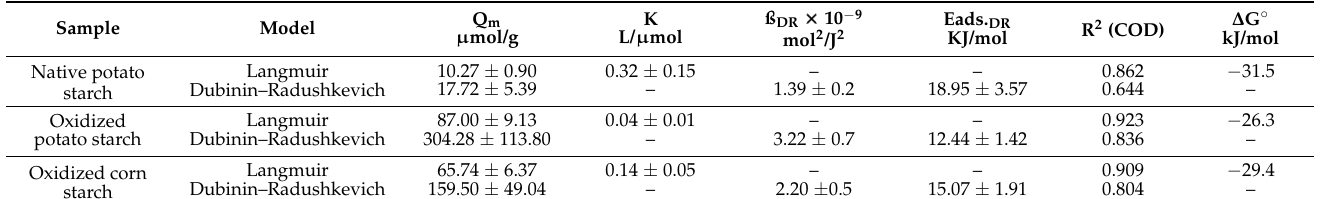
Table 3. Fitting parameters for the adsorption of Fe 2+ from FeSO 4 solution onto n. potato starch, o. potato starch, and o. corn starch for Langmuir and Dubinin–Radushkevich isotherm